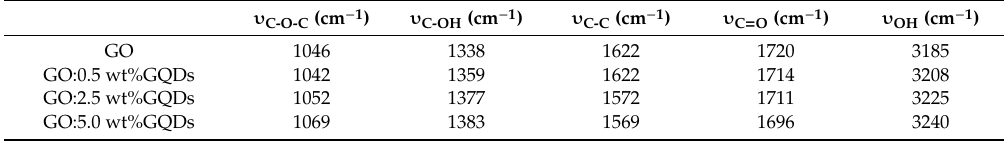
Figure 1. FTIR spectra of GO, and GO:GQDs nanocomposites. Table 1. Data for FTIR spectroscopy of GO and GO:GQDs